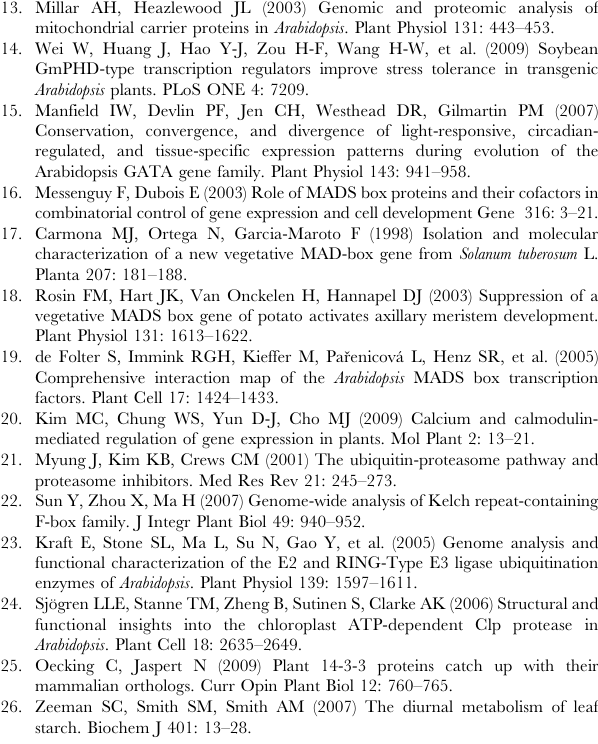
data. Data for TPS1 -transgenic (A) and wild-type plants (B) from nine microarrays were quantile normalised. Figure S2 Pathway map of carbohydrate metabolism. The map is based on the KEGG database (http://www.genome.